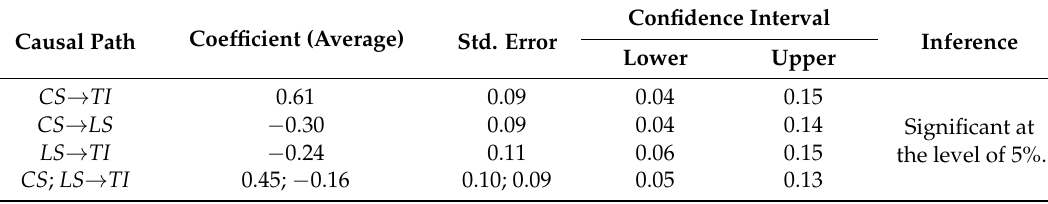
Table 14. Bootstrap estimation of the mediating effect of LS on the CS–TI relationship ( N:1000 ). (CS: Commuting stress, LS: Life satisfaction, TI: Turnover